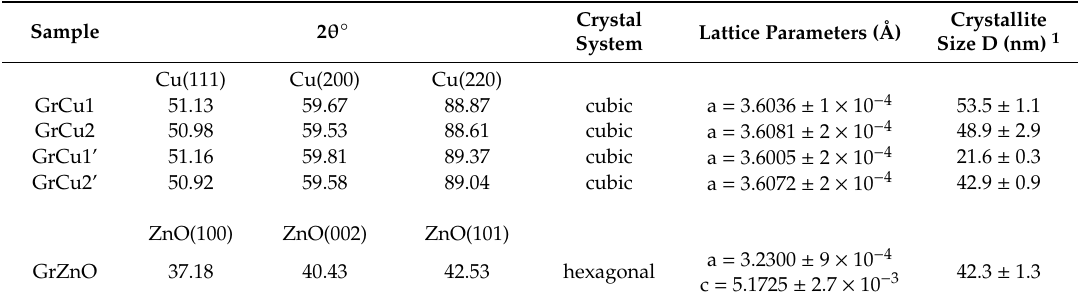
Table 3. Copper and zinc oxide peak positions, lattice parameters and crystallite sizes obtained from X-ray di ff raction patterns of graphene hybrids GrCu and